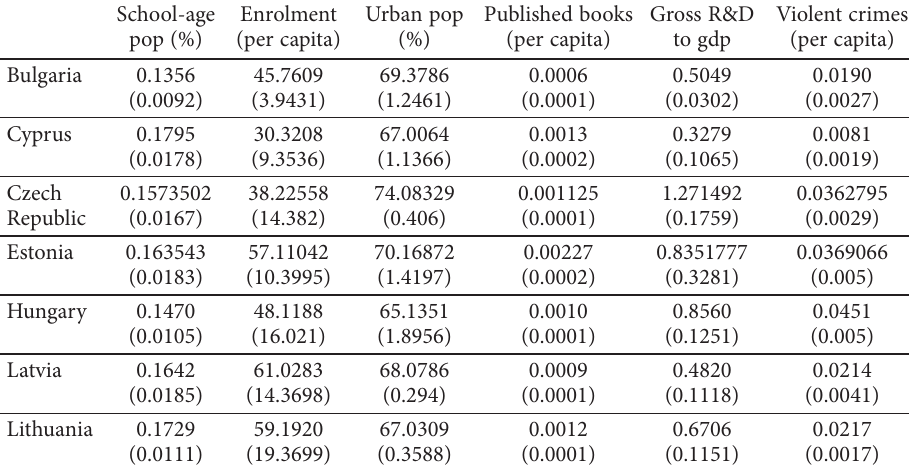
Table A.2. Summary statistics of control